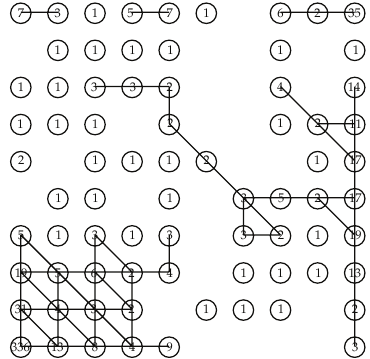
Figure 11: Cluster result of the Wisconsin breast cancer